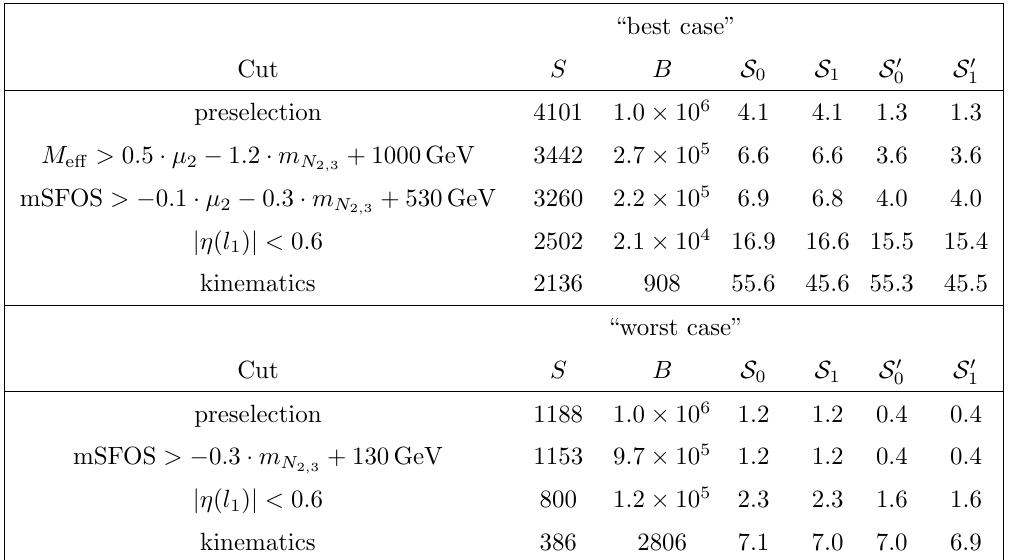
Table 7 . Cuts made for distinguishing signal and background at CLIC with a center of mass energy of 3 TeV and a luminosity of 5 ab (cid:0) 1 . We show the number of signal and background events together with the corresponding sensitivities for a benchmark point m N The results are shown both for \best" and \worst" case scenarios which correspond to maximizing couplings to e, (cid:22) and (cid:28) lepton, respectively. Details about the systematic errors are given in the